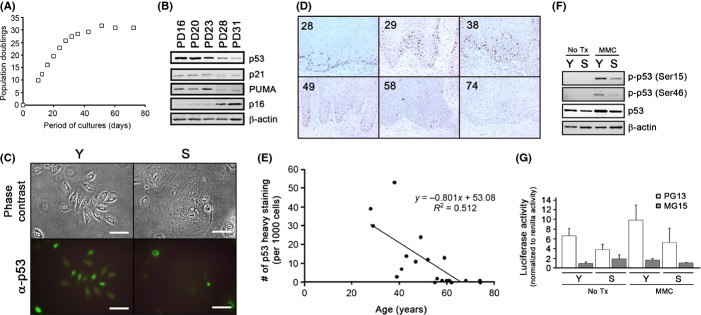
p53 protein expression progressively decreases in normal human keratinocytes (NHKs) and normal human oral epithelia (NHOE) during replicative senescence of in vitro and organismal aging in vivo. (A) The primary NHKs were serially subcultured until they senesced, and the population doubling curve was obtained. (B) NHKs at the different PDs were subjected to Western blotting for the expression of p53, p21, PUMA, and p16. β-Actin was used as a loading control. (C) Immunofluorescent staining was performed in young (Y) and senescent (S) NHKs using IgG (Not shown) or p53 antibody (DO-1) at 1:1000. The bar represents 100 μm. (D) Normal human oral epithelium (NHOE) from 20 healthy individuals were formalin-fixed, paraffin-embedded, sectioned, and subjected to immunohistochemical analysis for the expression of p53 (DO-1) at 1:100 concentration. The numbers at the upper-left corner of each photograph (100×) represent the age of the donors. (E) The representative field was randomly selected by a third person, and one thousand cells were counted for heavy staining (> 80%), moderate staining (40–80%), mild staining (5–40%), or no staining (< 5%). Only the heavy-staining cells were counted and plotted against the age. Linear regression analysis was performed (R2 = 0.512). (F) Young and senescent NHKs were treated with mitomycin C (MMC) (10 μm) and subjected to Western blotting for phosphorylated p53 at ser15 and ser46 residues. (G) Young and senescent NHKs were transfected with PG13- and MG15-luciferase reporter plasmids, treated with MMC (10 μm), and luciferase activities were measured. pRL-SV40 plasmid were cotransfected to normalize the luciferase signals. The experiments were triplicated.